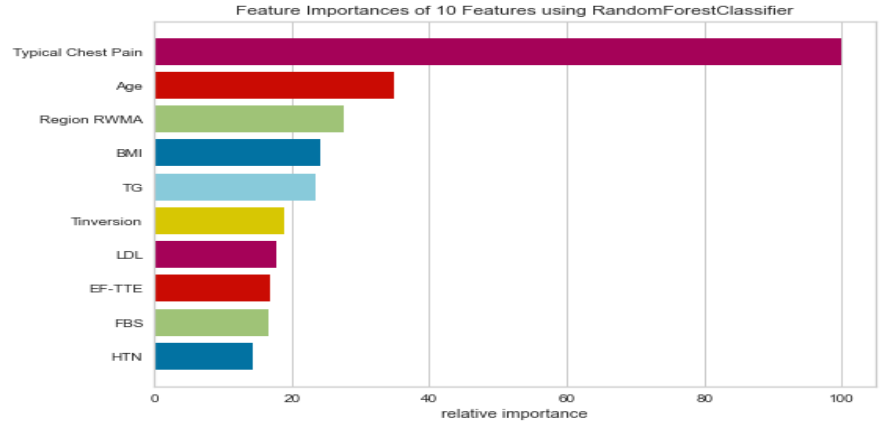
Figure 5. Feature importance using the RF-RFE model. ROC or AUC analysis is one of the most accurate measures for evaluating the efficiency of an imbalanced dataset; a desirable ratio is between 80% and 90%, and >90% is usually better. In Figure 6, the ROC curve versus the TP and FP ratios is displayed.